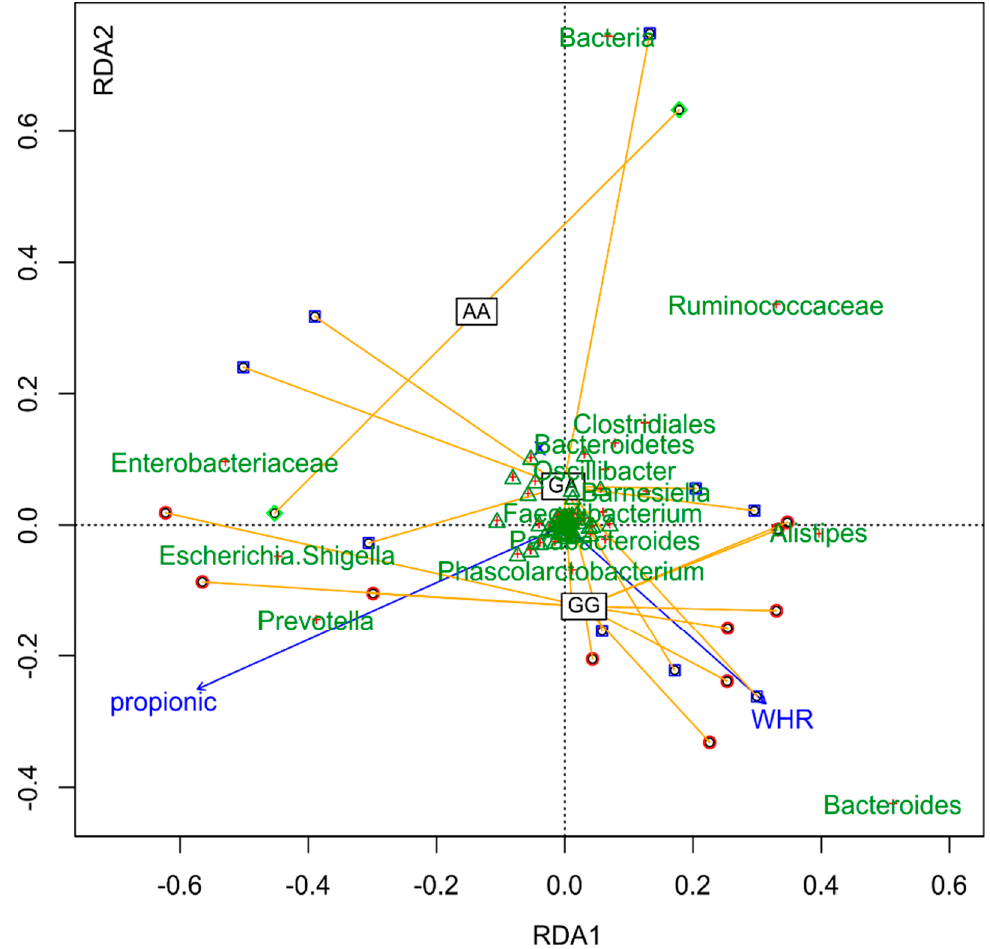
Figure 8. Factors determining differences between samples (distance ‐ based redundancy analysis (db ‐ RDA)).